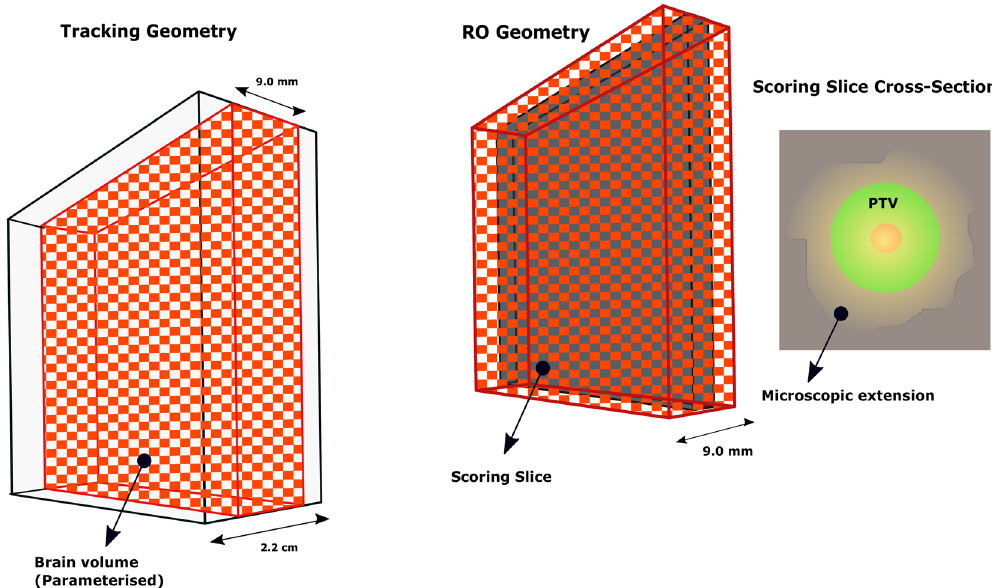
Figure 8. The real tracking geometry is shown on the left. A 9 cm × 9 cm × 2.2 cm box enclosed the brain volume (9 cm × 9 cm × 9 mm ) which was divided into 3 × 3 × 3 mm 3 and the material parametrisation was implemented for all voxels within. In the middle, the RO geometry is shown which consisted of the brain volume enclosing the scoring plane located in the middle of the volume and divided into 20 × 20 × 20 μ m 3 (the size of glioma cells). The RO geometry communicates in sync with tracking geometry to score the dose in the cells defined in the scoring plane. On the right, the cross section of the scoring plane is shown. It should be noted that this diagram is not to scale to allow illustration of